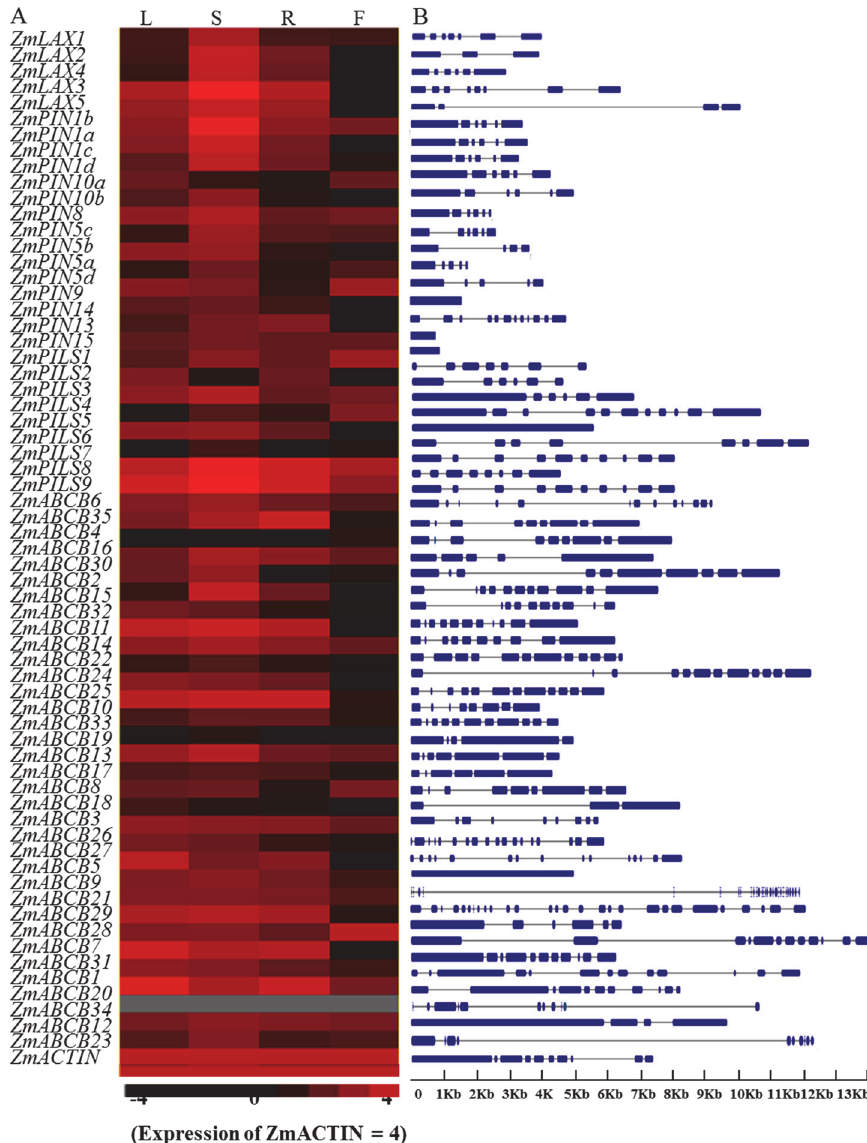
Fig 3. Tissues-specific expressions and exon-intron structures of ZmLAX , ZmPIN , ZmPILS and ZmABCB genes. (A) Tissues-specific expression patterns of ZmLAX , ZmPIN , ZmPILS and ZmABCB genes. L: leaf; R: root; S: shoot; F: flower. Levels of different colors were shown on a log scale from the high to the low expression of each ZmPIN , ZmPILS , ZmLAX and ZmABCB gene. The expression level of ZmACTIN or 18S RNA gene were defined as log (10000) = 4. (B) Exon-intron structure analysis of ZmLAX , ZmPIN , ZmPILS and ZmABCB genes. The exons were indicated by blue boxes; the introns were indicated by gray